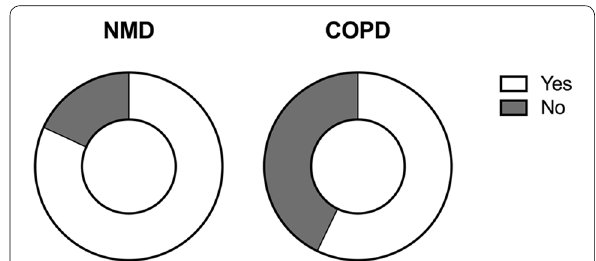
Fig. 3 Degree of satisfaction with history of tracheostomy according to underlying disease—question: In hindsight, would you choose tracheostomy for long-term invasive HMV again? NMD neuromuscu- lar disease, COPD chronic obstructive pulmonary disease, HMW home mechanical ventilation